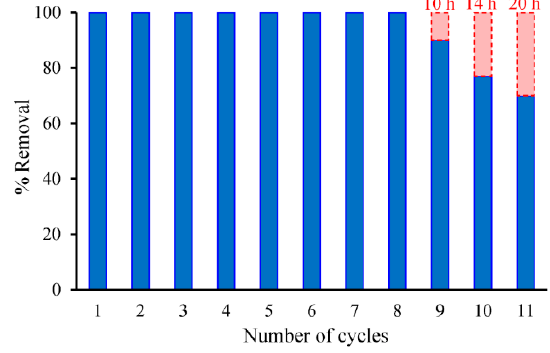
Figure 6. Reusability of the MCC.